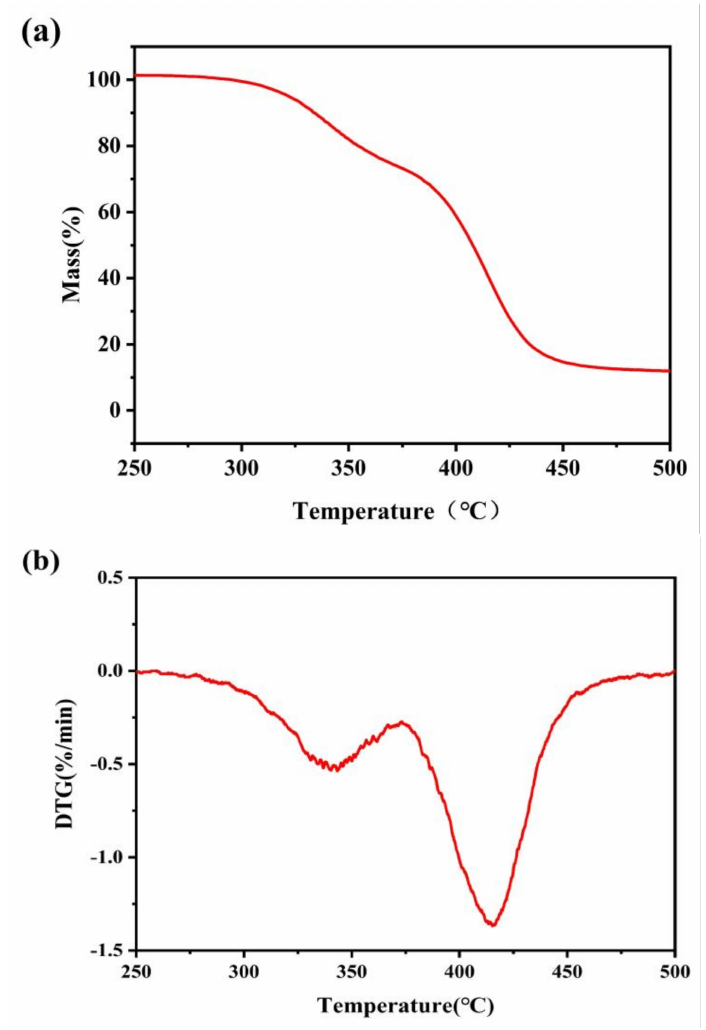
Figure 5. Thermogravimetric analysis (TGA) curve of TPSiU ( a ) and corresponding derivative thermogravimetric (DTG) curve ( b